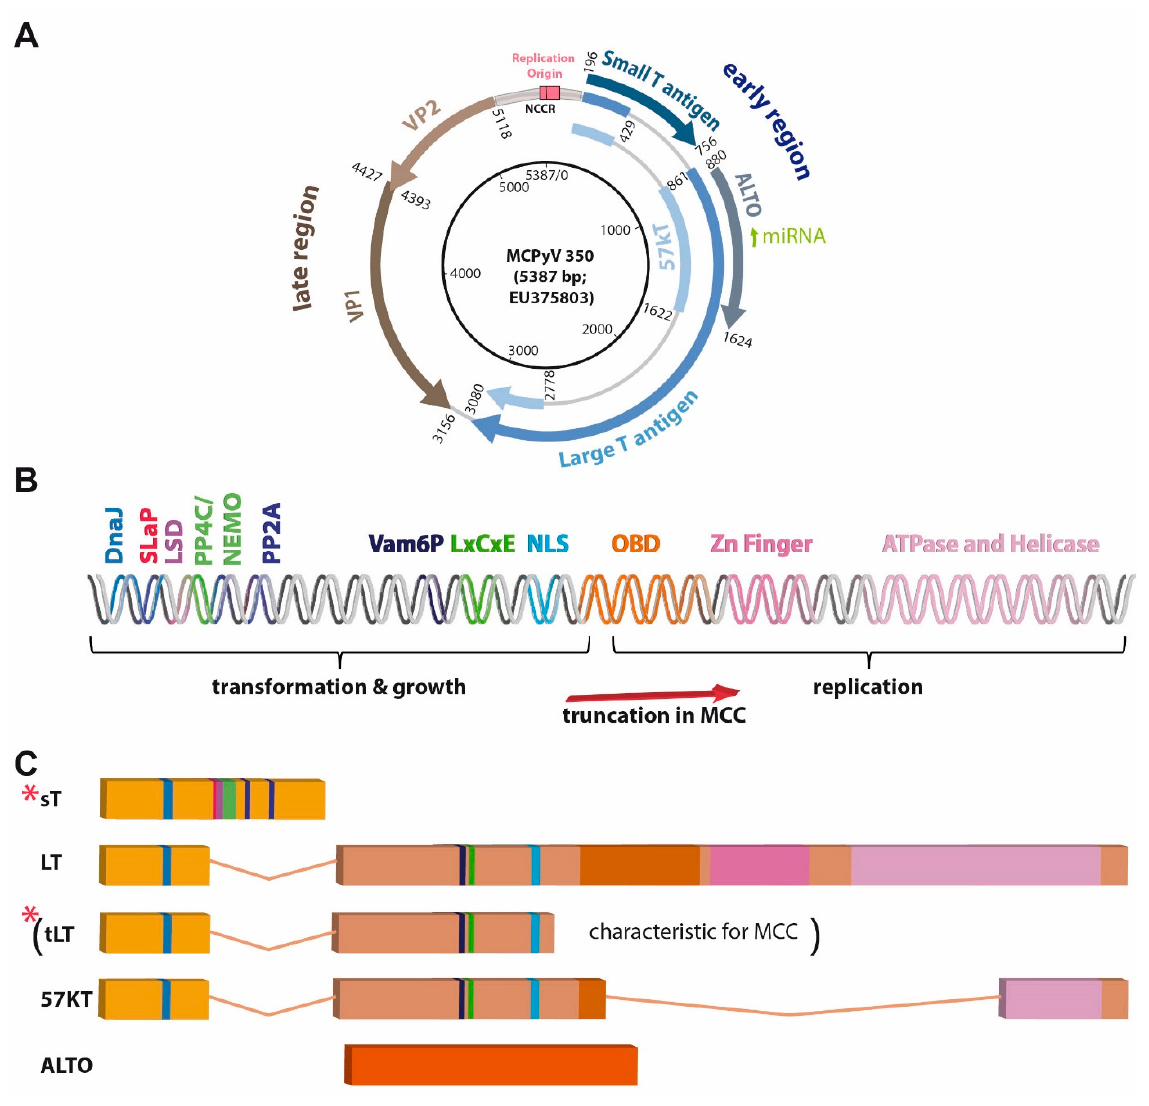
Figure 2. MCPyV genome, described domains, and motifs present in the T antigen region, and T antigen transcripts. ( A ) Map of circular MCPyV. ( B ) Linear map of T antigen (TA) region encoding the depicted motifs and domains. DNAJ: contains HSC70 binding site; LxCxE: RB1 interacting site; LSD: LT stabilizing domain; NLS: nuclear localization signal or sequence; OBD: